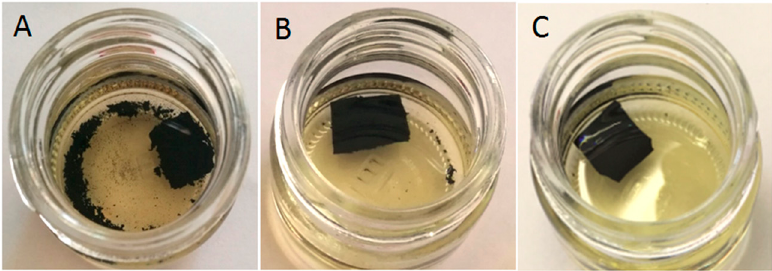
Figure 5. Samples after 72 h extraction in toluene: ( A ) GTR+TOR ‐ 180 °C; ( B ) GTR+EVA1 ‐ 180 °C; ( C ) GTR+EVA2 ‐ 180 °C.